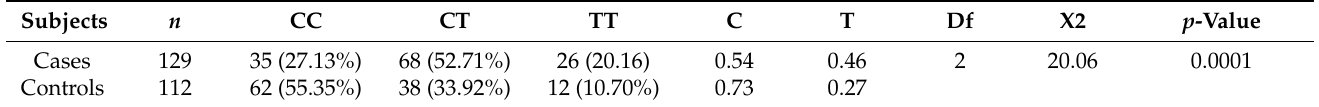
Table 5. Genotype distribution mir128 rs11888095 C/T genotypes in T2D cases and controls.